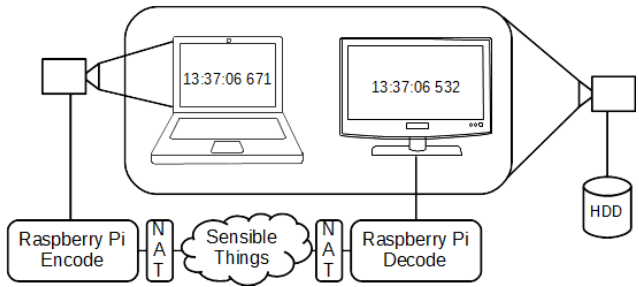
Figure 7. Measurement setup with SensibleThings with Network Address Translation (NAT) IP.